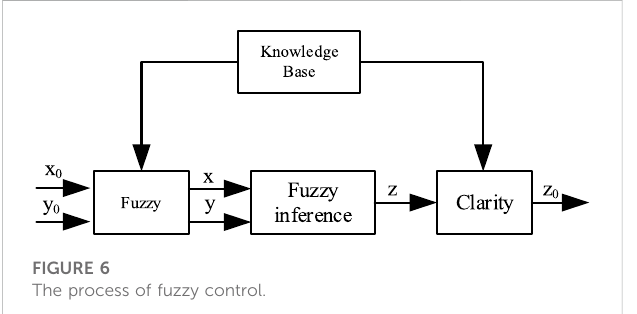
FIGURE 6 The process of fuzzy